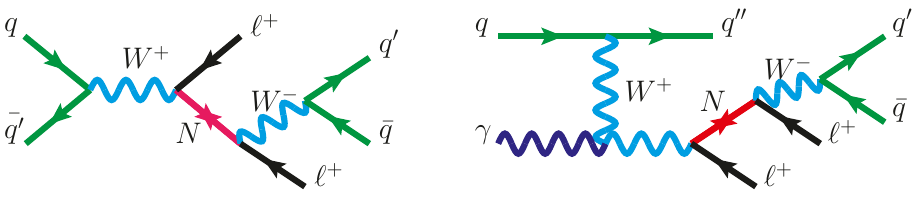
Figure 1 . Feynman diagram representing a resonant production of a Majorana neutrino (N), via the s -channel Drell-Yan process (left) and its decay into a lepton and two quarks, resulting in a (cid:12)nal state with two same-sign leptons and two quarks from a W boson decay. Feynman diagram for the photon-initiated process